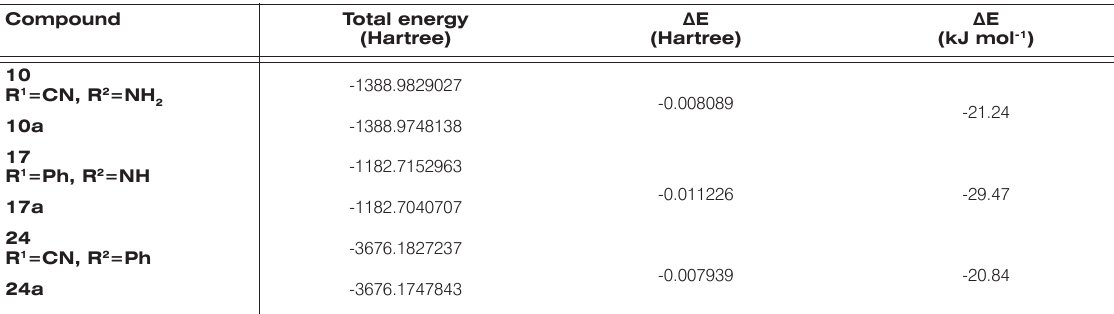
Table 1. Comparison of calculated energies of selected compounds. Compound